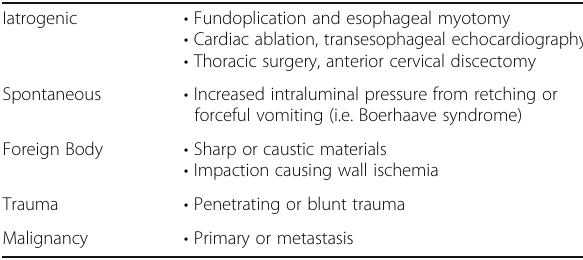
Table 2 Causes of esophageal perforation